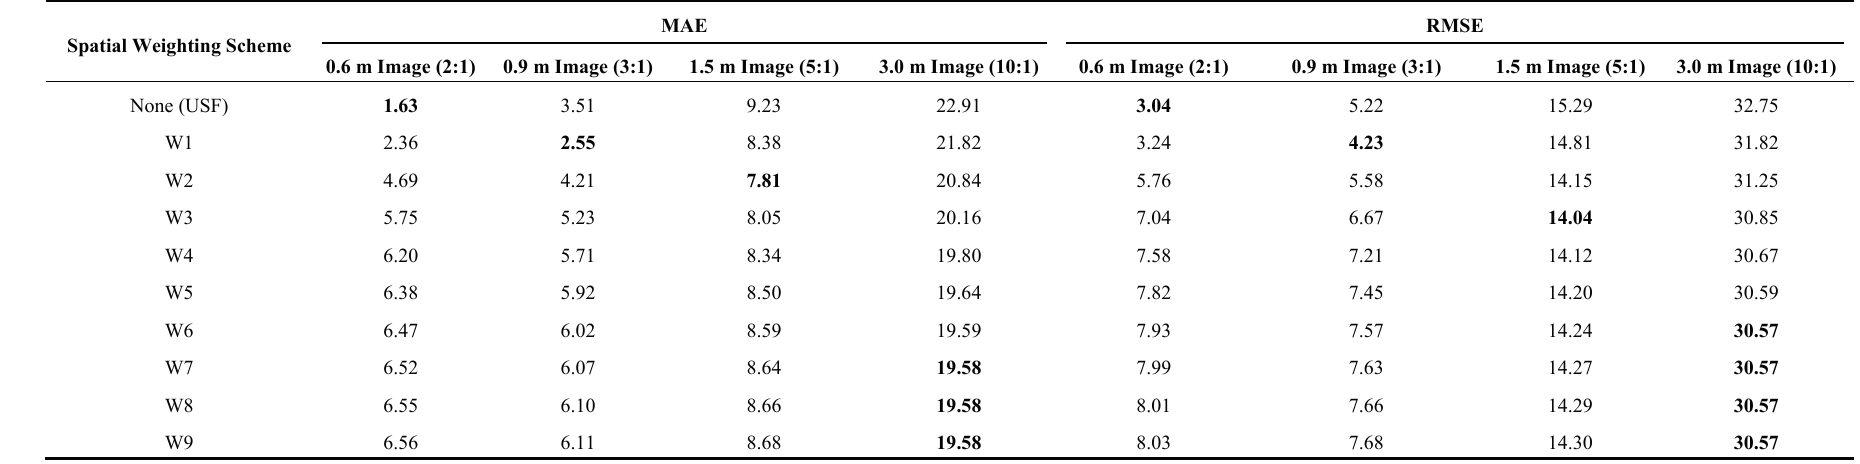
Table 1. Mean Average Error (MAE) and Root Mean Square Error (RMSE) of the mean segment values extracted from the lower spatial resolution images. Bold values indicate the lowest MAE and RMSE values for each image. USF, unweighted segment-level fusion approach; W1–W9, spatial weighting schemes